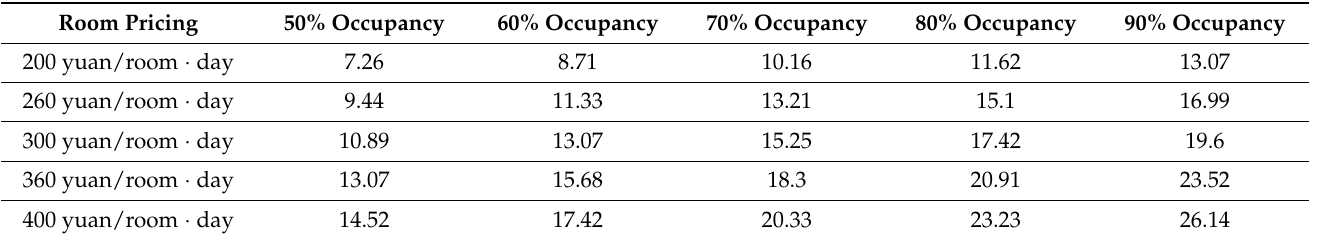
Table 2. Annual expected income of Xiniu village single homestay under different room pricing and occupancy rates. (unit: 10,000